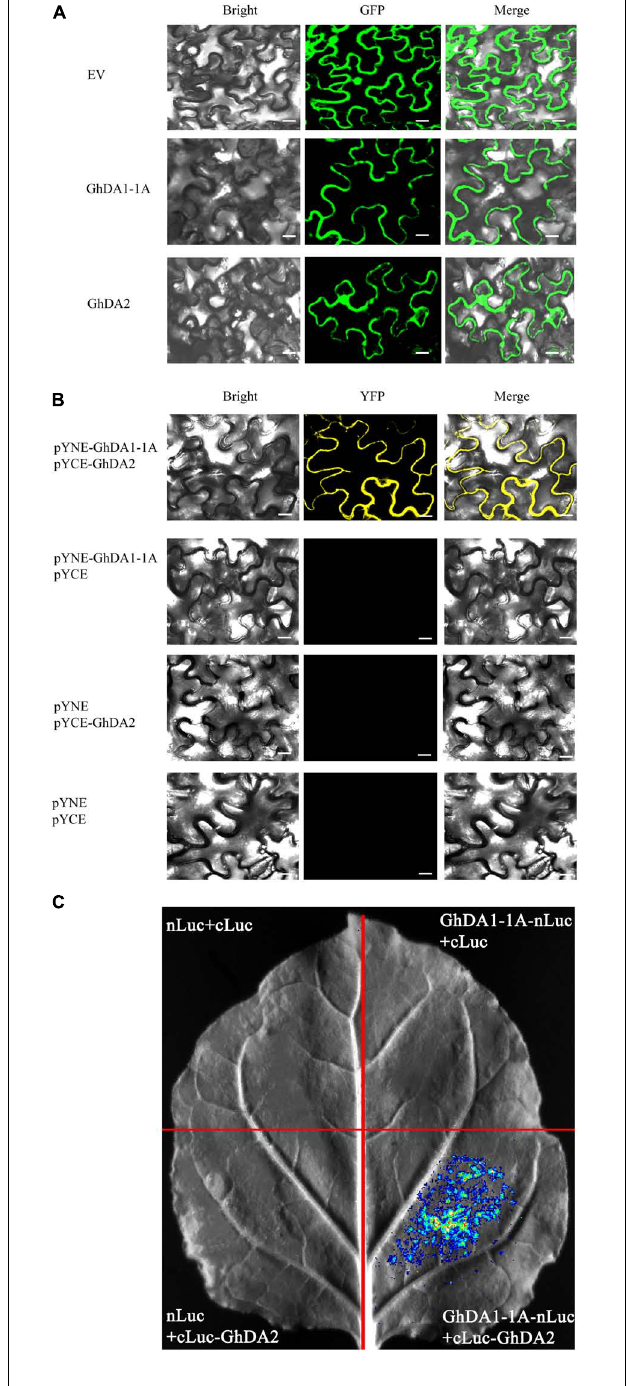
FIGURE 7 | The subcellular localization and interaction of GhDA1-1A and GhDA2 (A) Subcellular localization of 35S-GhDA1-1A-GFP and 35S-GhDA2-GFP. (B) BiFC analysis of the interactions between GhDA1-1A and GhDA2. The pYNE-GhDA1-1A and the pYCE-GhDA2 were co-expressed into N. benthamiana leaf cells. The yellow fluorescence was detected 2 days later. (C) Firefly luciferase complementation imaging assay showing the interactions between GhDA1-1A and GhDA2. GhDA1-1A-nLUC and cLUC-GhDA2 were co-expressed in N. benthamiana leaf cells. Luciferase activity was detected 2 days after